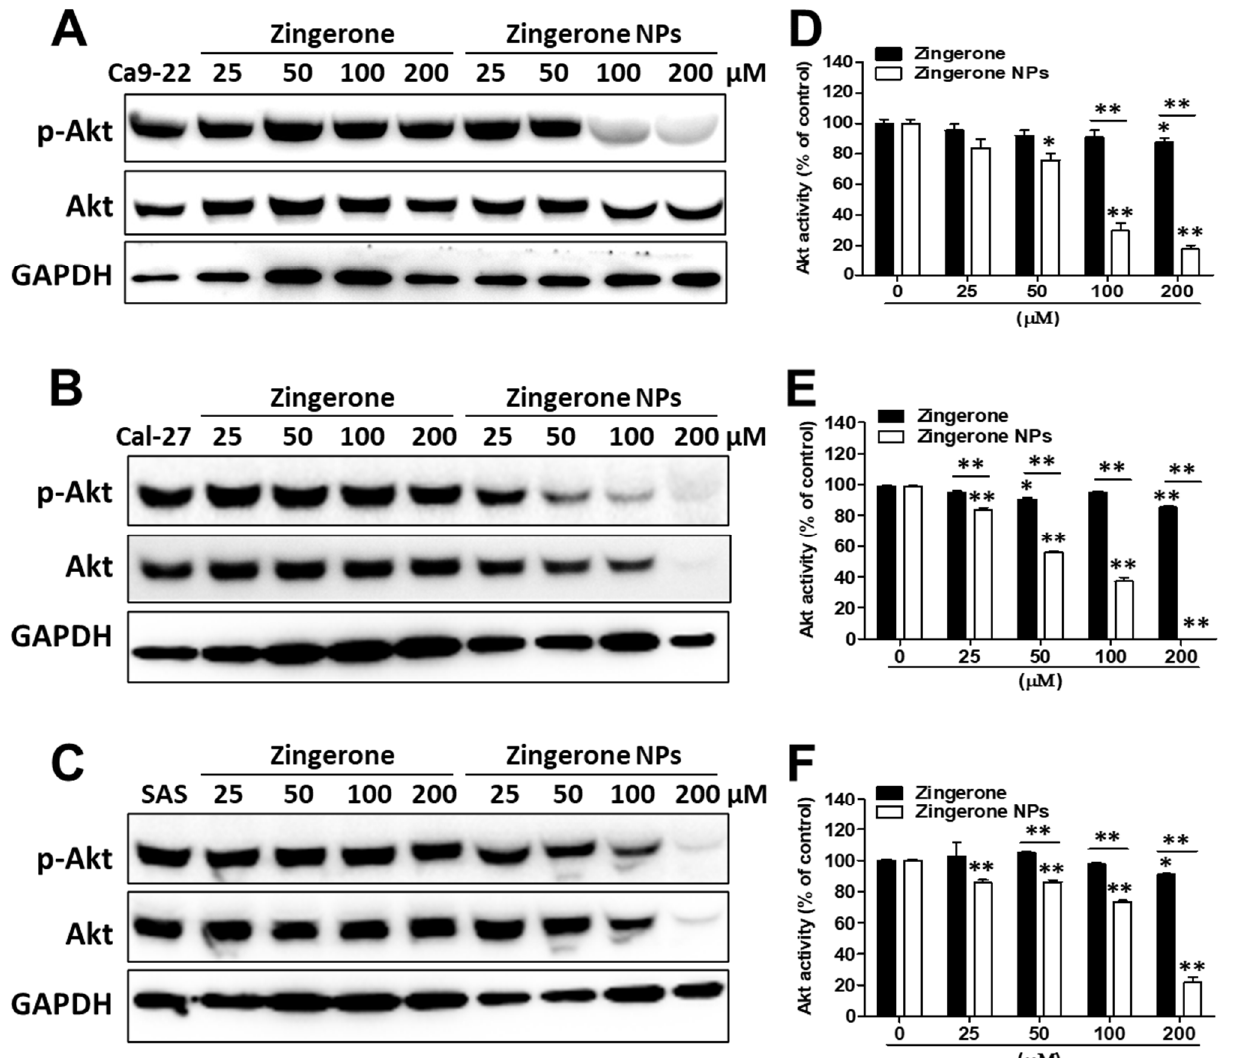
Figure 5. Effect of zingerone NPs on Akt activity of human OSCC cell lines. Cells were treated with zingerone and/or zingerone NPs for 24 h. The Akt activity was detected on ( A ) Ca9-22 cells, ( B ) Ca1-27 cells, and ( C ) SAS cells, respectively using Western blotting. The Akt activity was further analyzed and quantitated for ( D ) Ca9-22 cells, ( E ) Ca1-27 cells, and ( F ) SAS cells. Data are expressed as mean ± SEM of three experiments. * p < 0.05, ** p <